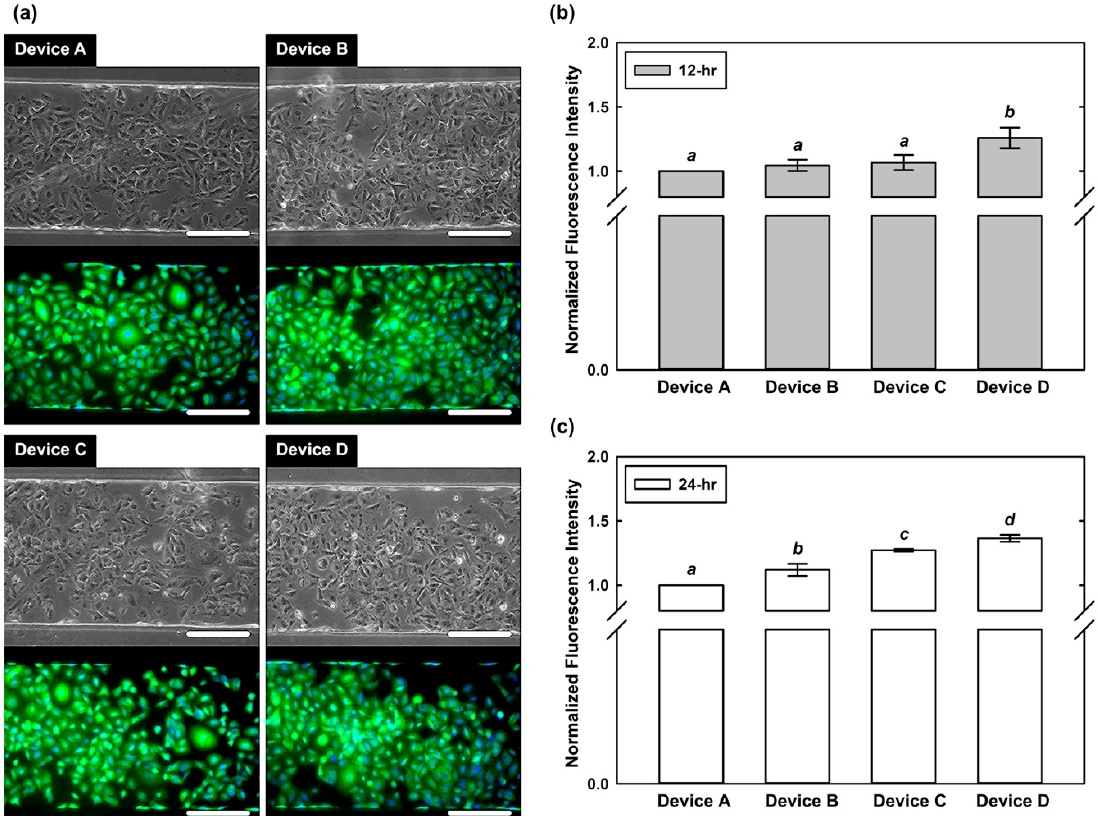
Figure 5. ( a ) Bright field phase and fluorescence images of the A549 cells cultured within the microfluidic devices with different combinations of steroid treatment and physical stimulation. Device A: neither steroid treatment nor physical stimulation (control); Device B: only steroid treatment; Device C: only physical stimulation; Device D: steroid treatment and physical stimulation. ( b,c ) Normalized average fluorescence intensity showing SPC expression of the A549 cells after 12- and 24-h experiments under the four different conditions, respectively. The fluorescence intensities showing SPC expression levels with statistically significantly different are designated with different letters (a, b, c, d = p < 0.05).